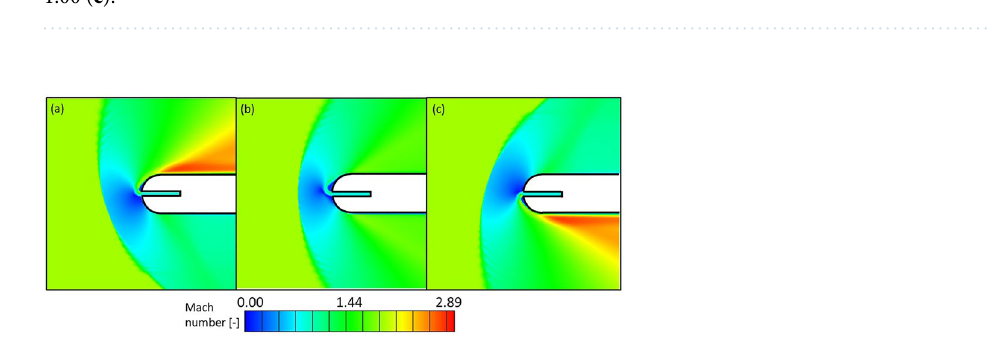
Figure 18. Leading edge region Mach number contours for Re dc = 1.00 × 10 4 and M c = 0.85 , α 1 = − 20 ( a ), 0 ( b ) and 20° ( c